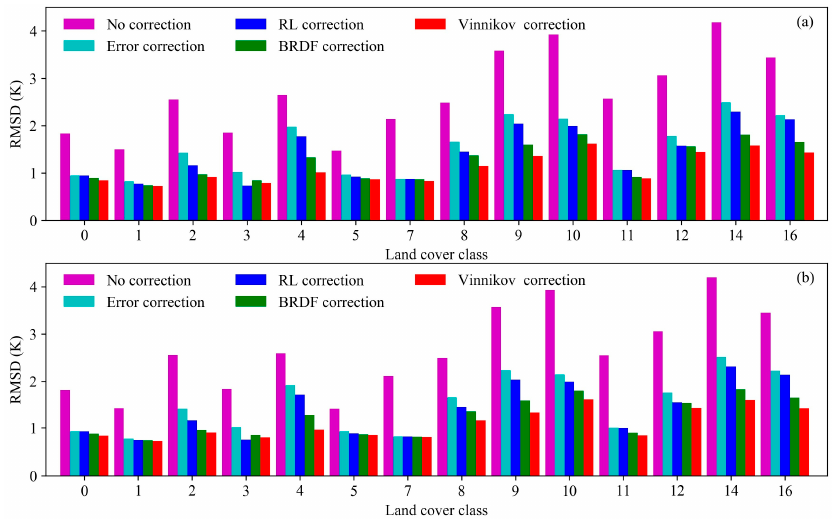
Figure 7. Histograms of root mean square differences (RMSD) between MODIS and AATSR land surface temperatures (LSTs) for no correction (magenta), using the error correction (cyan), and using the angular correction with the RL model (blue), the BRDF model (green), and the Vinnikov model (red) for ( a ) verification and ( b ) validation.